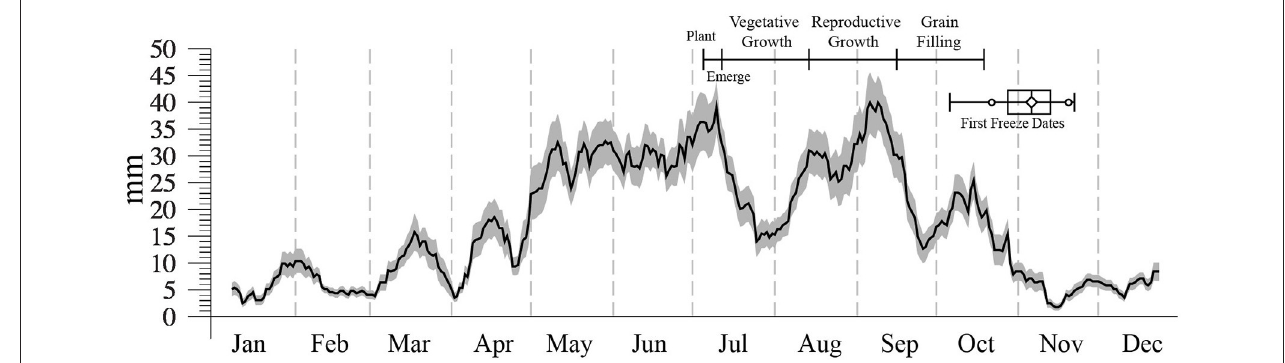
FIGURE 6 | Black trace marks the average of running 15-day rainfall totals over Figure 1 ’s 21 WTM stations during each year of 2005–2016 ( n = 252). Gray error bars mark ± 2 σ uncertainty in the means. Barplot shows the percentiles of first hard freeze dates (daily T min < − 2.2 ◦ C) for each of the 252 station-years. Crop development timeline marks growth phases for a medium maturity sorghum cultivar planted on July